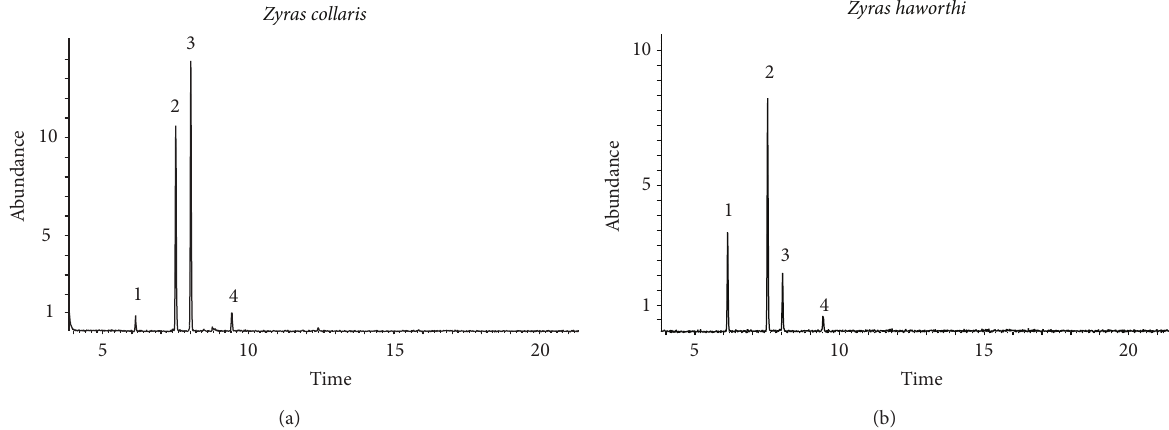
Figure 1: Gas chromatograms (TIC) of the tergal secretions obtained by stir bar irritation of Zyras collaris (a) and Z. haworthi (b). 1: 𝛼 -pinene; 2: 𝛽 -pinene; 3: myrcene; 4: limonene.